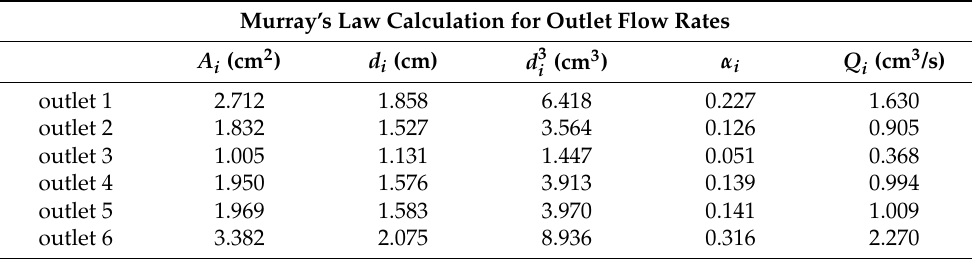
Table 2. Experimentally obtained input parameters for simulation of CT209 . Table 6. Initial calculated flow rates at each outlet by Murray’s law for CHN13